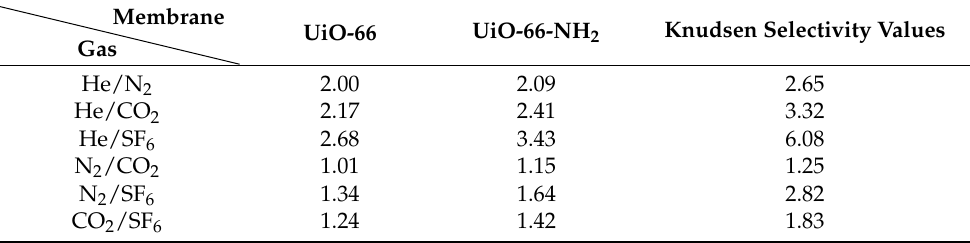
Table 1. Ideal selectivity factor of different gas through the membranes (under ΔP = 1 bar).